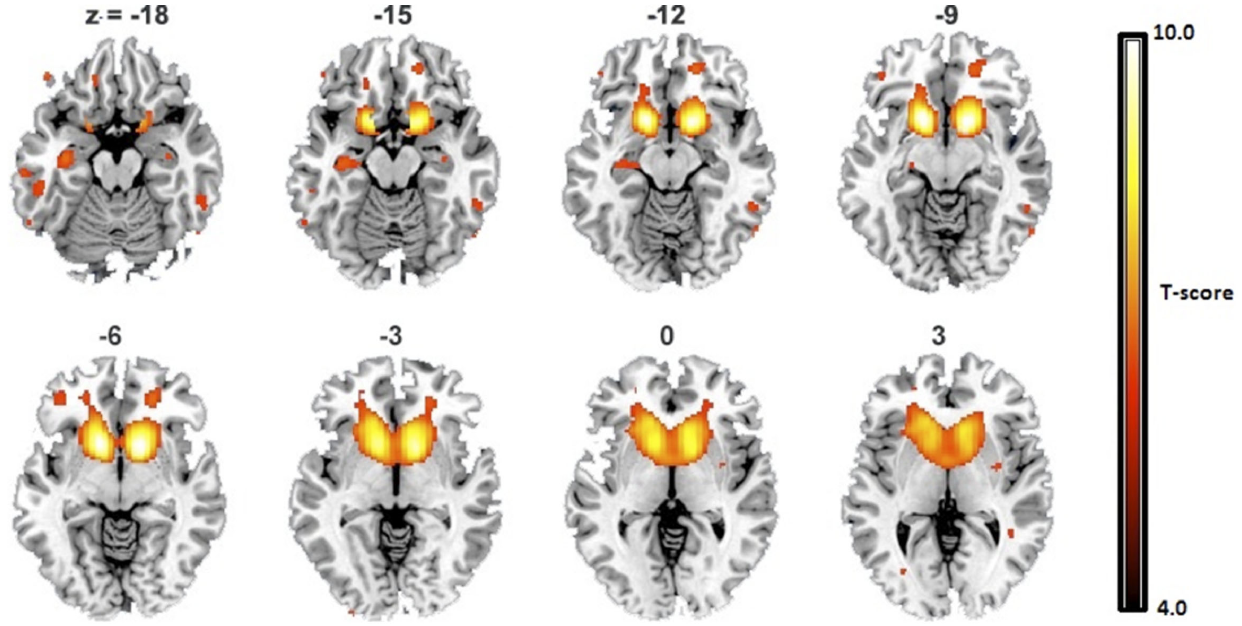
Figure 3. Reward Network. One-sample t-maps of the Reward-Punishment contrast for all subjects ( n =69) were used to construct the ‘‘reward network’’. The threshold was set at p , 0.05 FWE whole-brain corrected. Axial slices are depicted from z= 2 18 mm to z= + 3 mm.